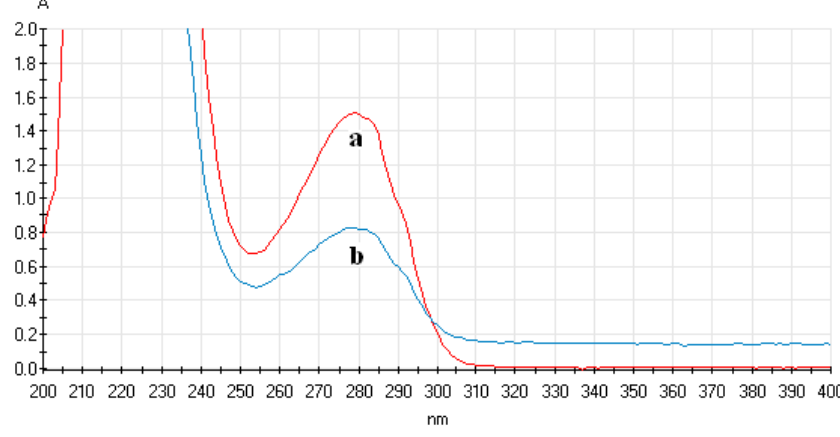
Figure 3. UV-Vis spectrum of SPA solution before and after binding to magnetic nanoparticles ( a : UV-Vis spectrum of 240 µg of SPA solution before binding to magnetic nanoparticles; b : UV-Vis spectrum of 240 µg of SPA solution after binding to magnetic nanoparticles).